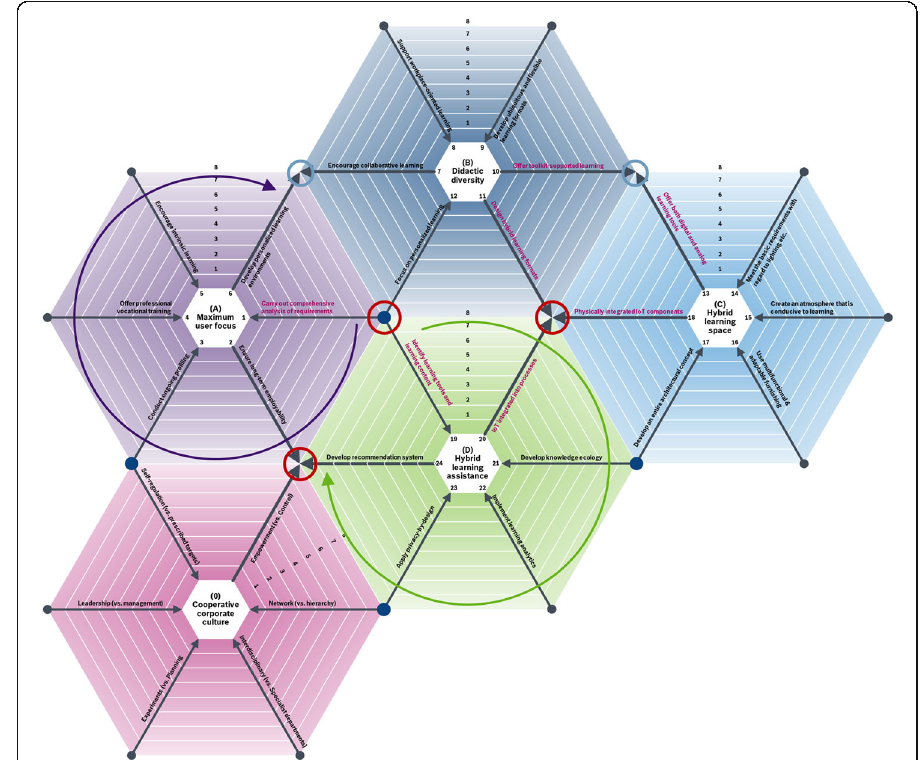
Fig. 1 SLE framework with the five design